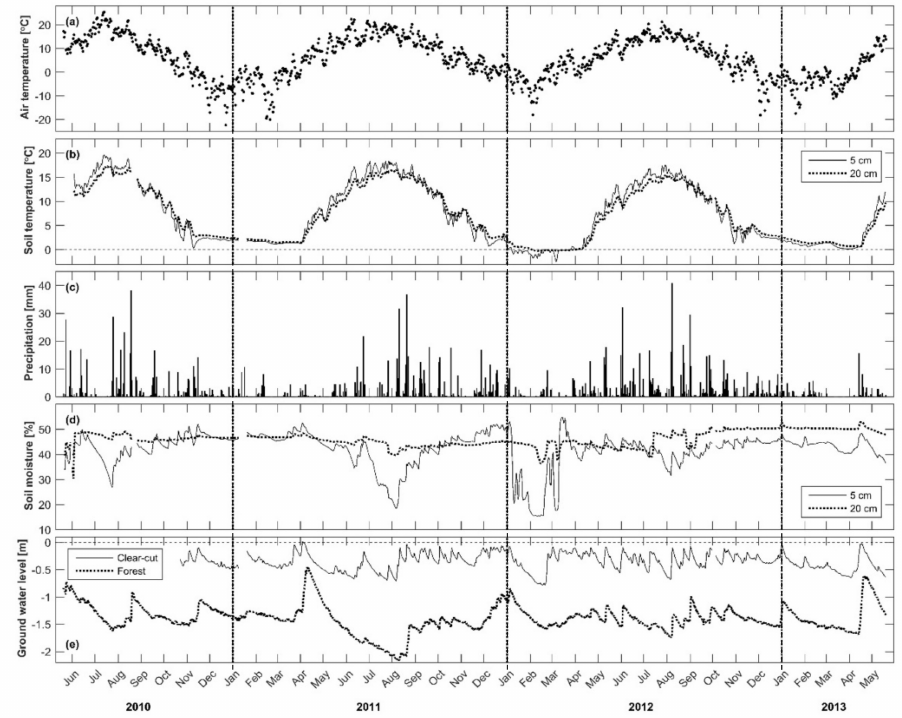
Figure 5. Environmental conditions measured at the clear-cut in Norunda from 1 June 2010 to 20 May, 2013. ( a ) Daily mean air temperature ( ◦ C) measured at 2 m height at the center of the clear-cut. ( b ) Daily mean soil temperature ( ◦ C) at 5 and 20 cm depth, measured at plot 2, close to the edge of plot 1. ( c ) Daily sum of precipitation (mm), measured at the center of the clear-cut. ( d ) Daily mean soil moisture (%) at 5 and 20 cm depth, measured at plot 2, close to the edge of plot 1. ( e ) Daily mean groundwater level at plot 2 and at the nearby mature forest. Vertical dashed lines mark the start of a new